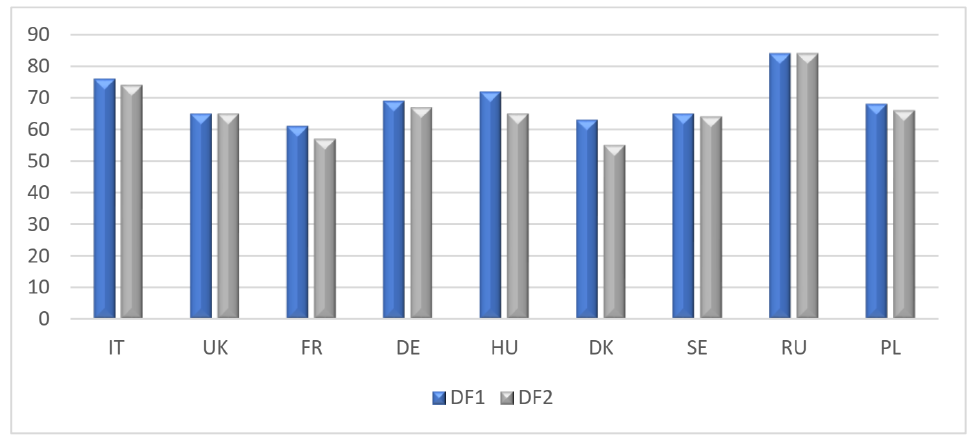
Figure 1. Overview on the approval of DF1 and DF2 nudges in the eight European countries and